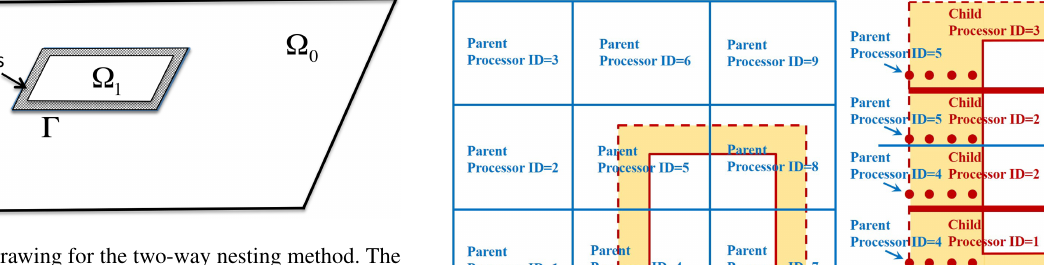
Figure 2. Schematic drawing for the two-way nesting method. The parent grid (cid:127) 0 has a coarse-resolution grid, while the child grid (cid:127) 1 is high resolution. Ghost cells (four rows) are specified along the inter-grid boundary, (cid:48) .